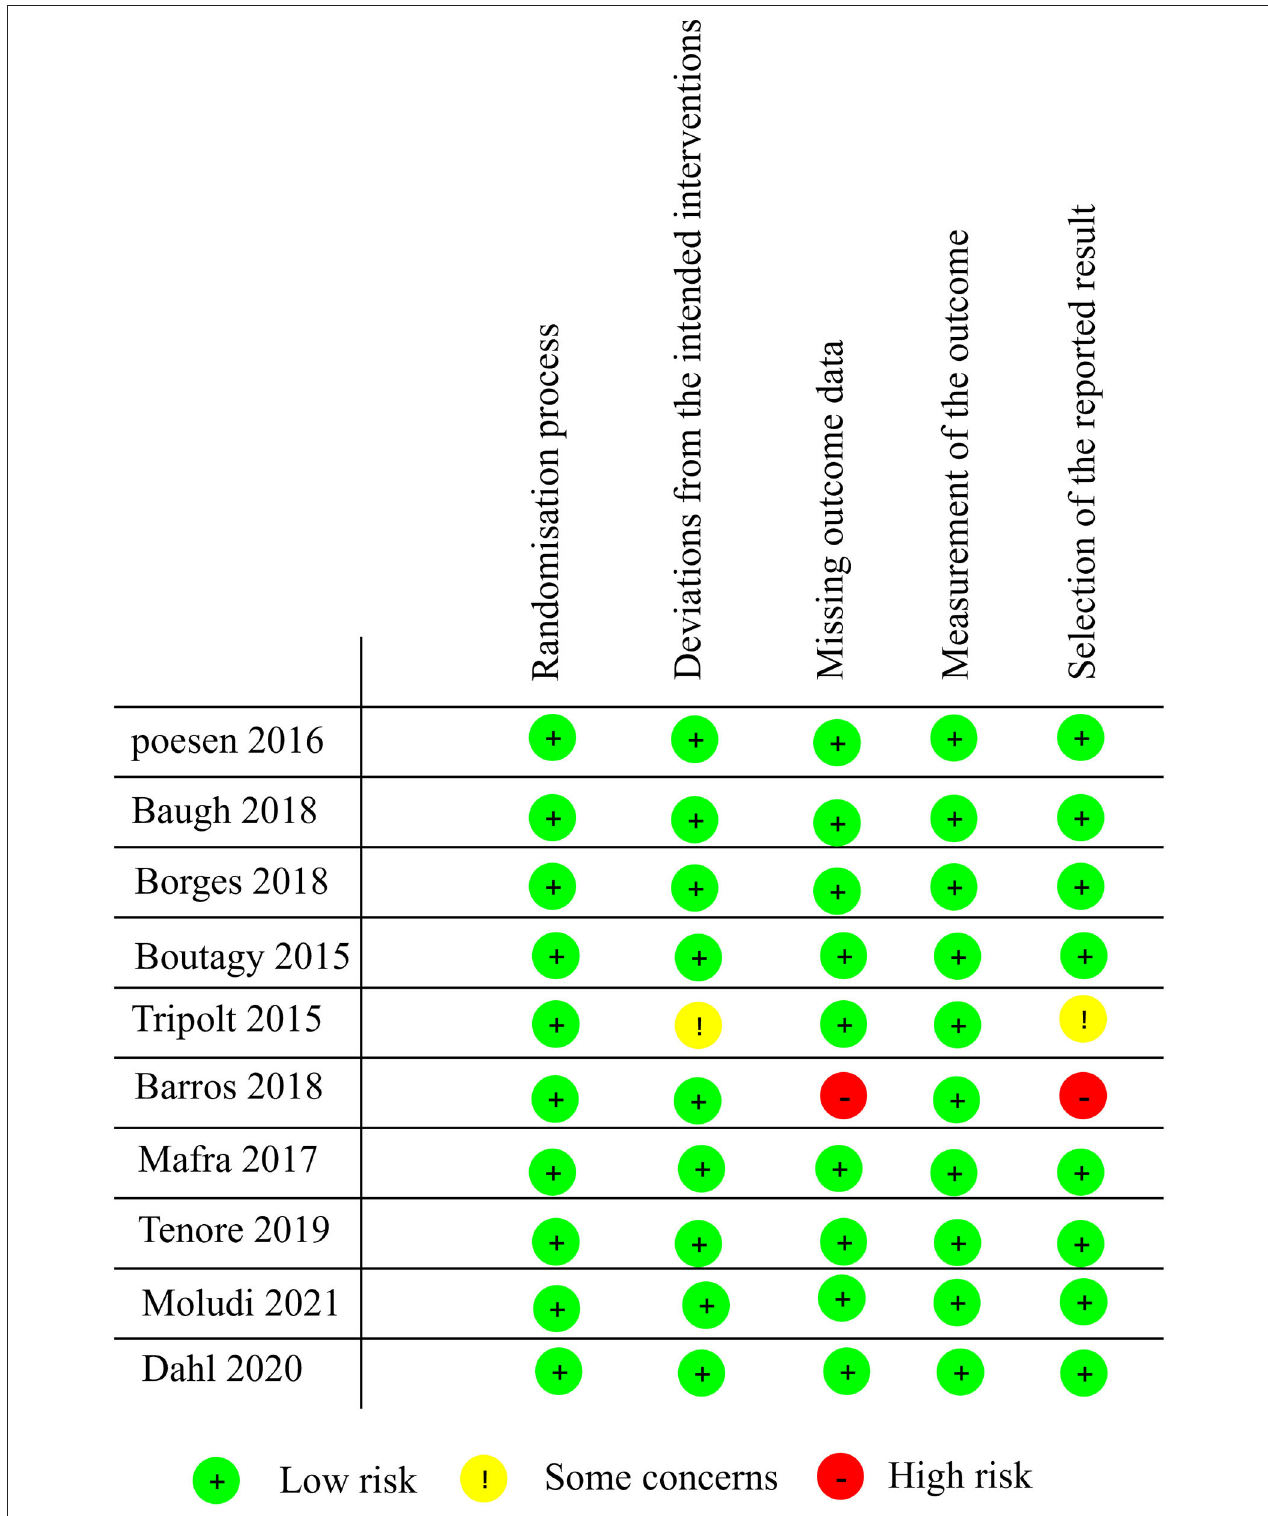
FIGURE 3 | Summary of the quality evaluation of the literature (RoB 2.0).